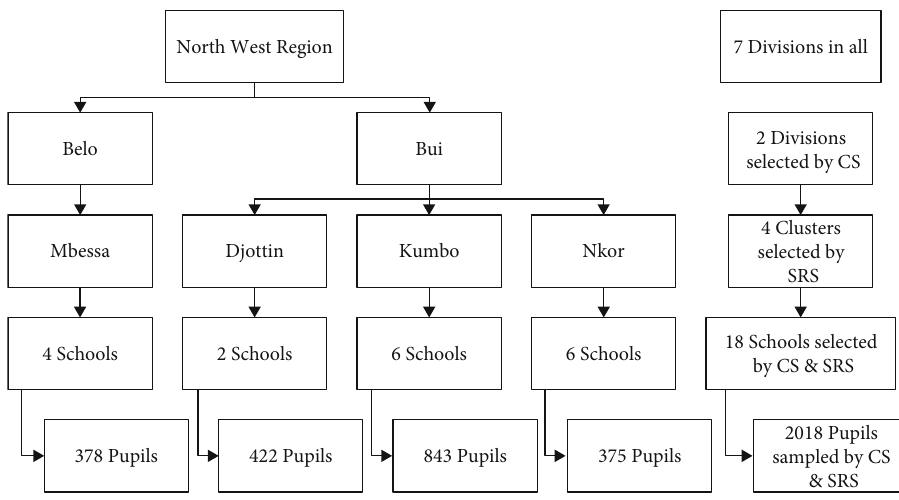
Figure 1: Multistage sampling of pupils (CS: convenience sampling; SRS: simple random